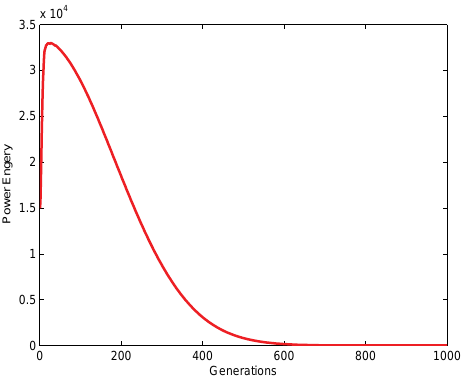
Figure 5: Power energy of all solutions in the evolutionary process